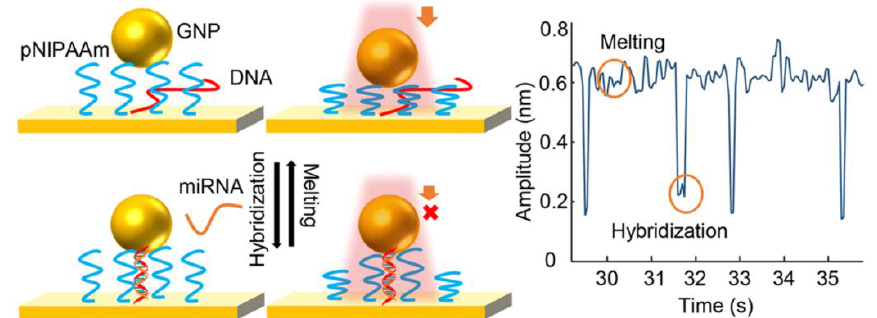
Figure 9. Gold nano-oscillators that are able to detect single molecule binding of miRNA due to the Figure 9. Schematic showing the high-amplitude light-induced oscillation of gold nanoparticles formation of a rigid structure that decrease the amplitude of the oscillations. Reprinted with in absence of target miRNA ( top ) and decrease of the oscillation amplitude after formation of a DNA-miRNA rigid duplex structure in the gap between the nanoparticle and the surface ( bottom ). permission from [278] Copyright 2018 American Chemical Society. Monitoring the oscillation amplitude provides information about individual binding and melting events of single miRNA molecules ( right ). Reprinted with permission from [278] Copyright 2018 American Chemical